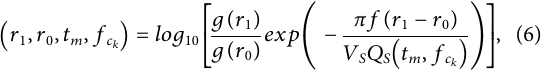
period (horizontal black segments in Figure 4A). Moreover, Figure 4B is a 2-D representation of the fl uctuations of the seismic attenuation parameter around its average value, Δ Q − 1 ( t ) , with the indications of the events of the m ,f S sequences with M ≥ 4.5 (epicenters in map of Figure 4C). The ( f ) 〉 is shown in time-averaged attenuation parameter 〈 Q − 1 S Figure 4D (averages calculated in two consecutive time windows: pre- and post-Amatrice. Note the reduction in the average attenuation parameter at low-frequency, in the second ( f ) 〉 is described by a power time window. Note also that 〈 Q − 1 S law at high frequencies, but fl attens just below 1 Hz, indicating that below 1 Hz, surface waves dominate between the two distances that are arbitrarily chosen to calculate the attenuation